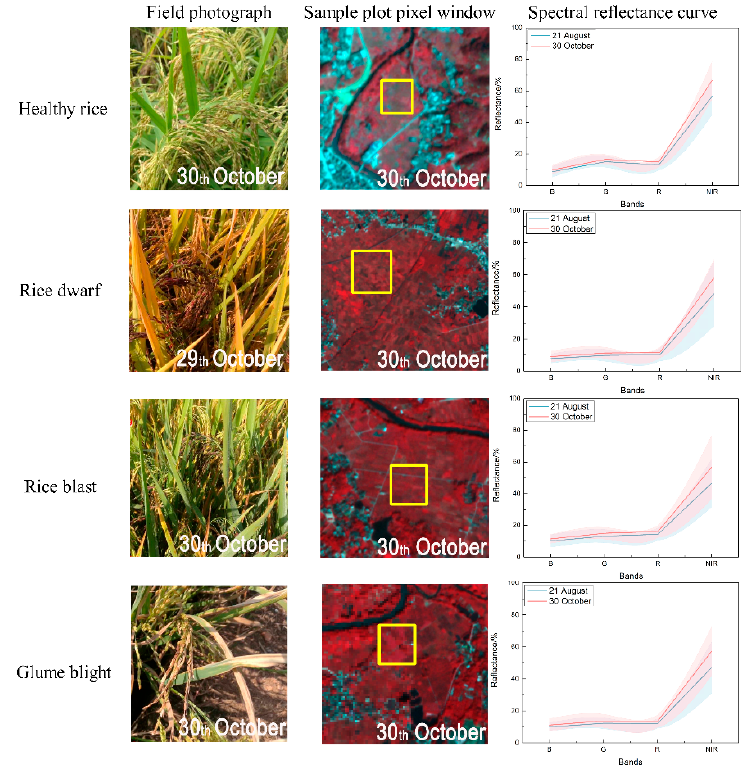
Figure 2. The representative samples for healthy rice and rice infested with dwarf, blast, and glume blight. Plots on the right show averaged spectral reflectance and deviation (the shadows) of each class collected on 21 August and 30 October.